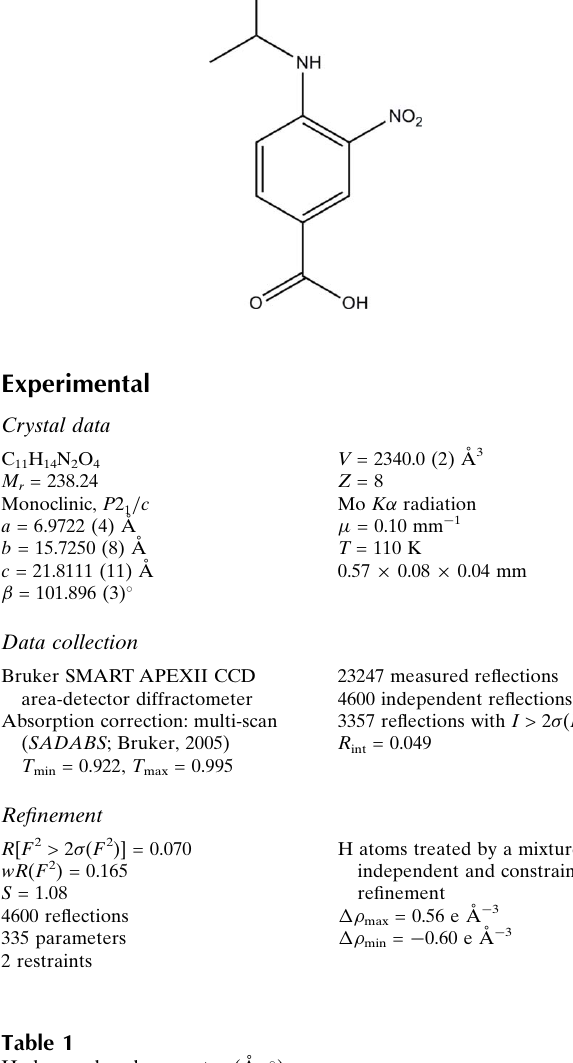
Hydrogen-bond geometry (A˚ , (cid:3)